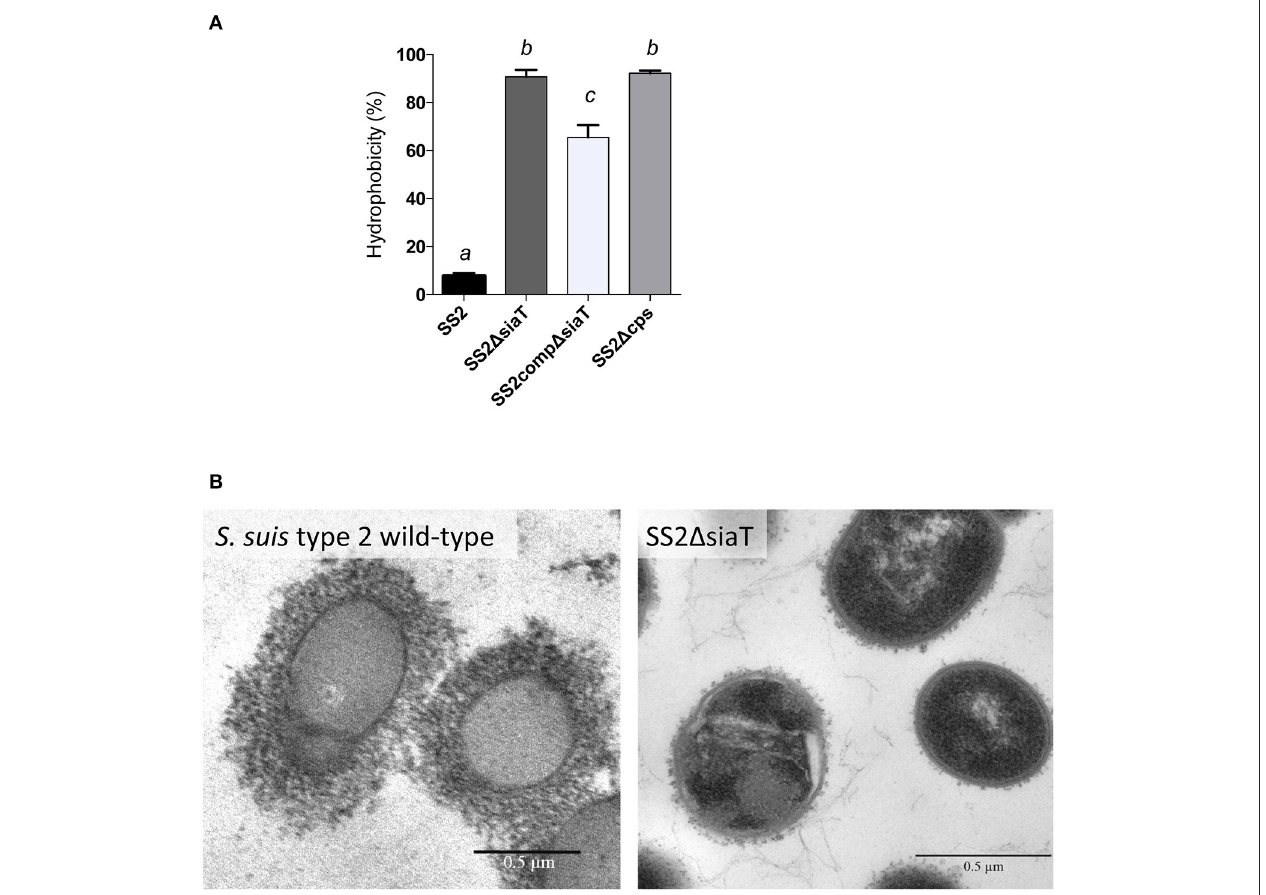
FIGURE 4 | Capsular polysaccharide (CPS) expression levels of S. suis serotype 2 and derived isogenic mutants. (A) Hydrophobicity (%) of the wild-type S. suis serotype 2 strain (SS2), the sialyltransferase SS2 1 siaT ( 1 cps2N ) mutant, the complemented SS2comp 1 siaT mutant, and of the non-encapsulated strain (SS2 1 cps ) used as control. Data are expressed as mean ± SEM of at least three independent experiments. Student’s t -test analyses reported significant differences between “ a” and “ b” , between “ a” and “ c” , and between “ b” and “ c” ( P < 0.05). (B) Transmission electron micrographs showing CPS expression by S. suis serotype 2 wild-type strain and its sialyltransferase SS2 1 siaT ( 1 cps2N ) mutant. Bars = 0.5 µ